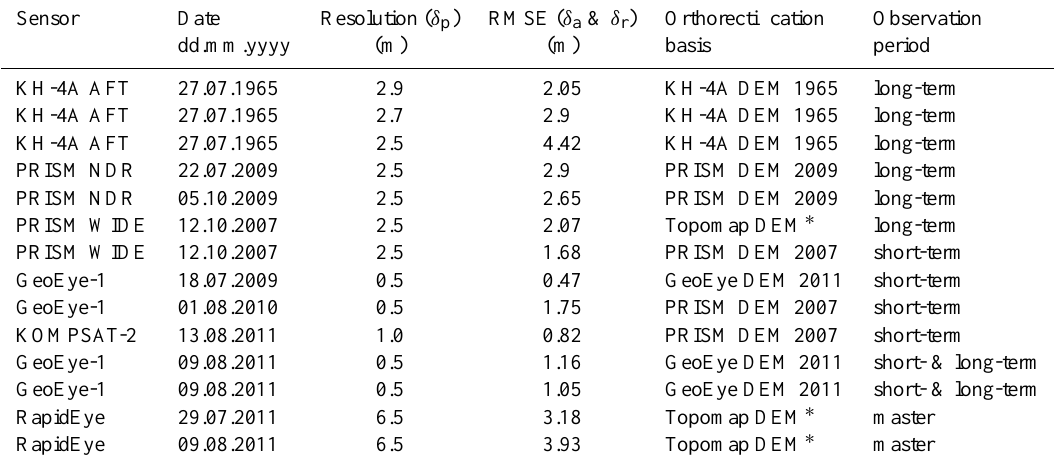
Table 1. List of remote sensing data used for determination of thermo-erosion along the coast of Mamontov Klyk and corresponding charac- teristics.